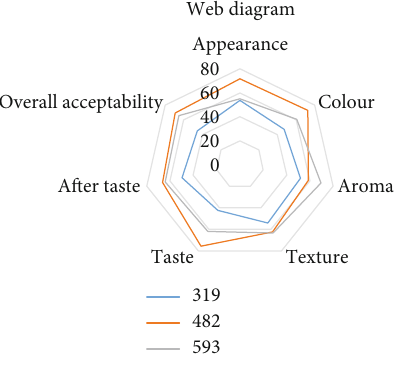
Figure 3: Web diagram for the sensory evaluation of the three mu ffi n